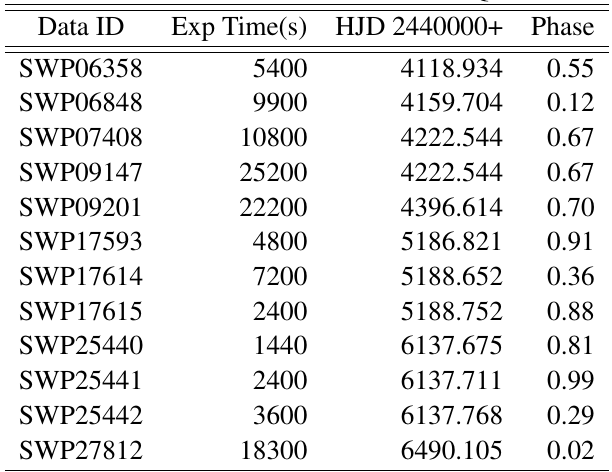
Table 1 List of IUE observations for DQ Her.